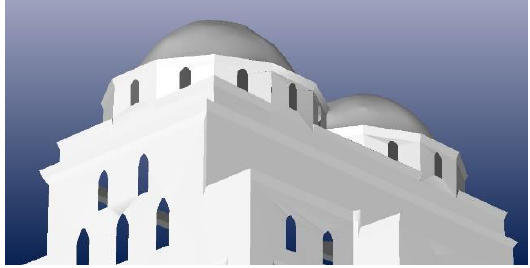
Figure 8. 3D models of Mosque’